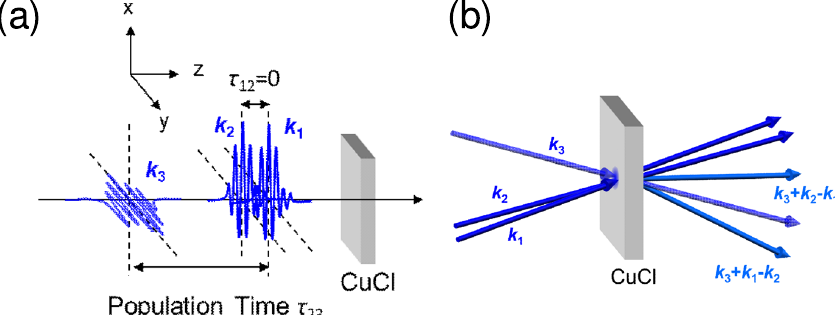
Figure 5. ( a ) Time-ordering and ( b ) schematic in the transient grating (TG) experiment. Here, k 1 and k 2 are x - polarized light, and k 3 is y -polarized light. Population time τ 23 corresponds to the delay time between k 1 , k 2 , and k